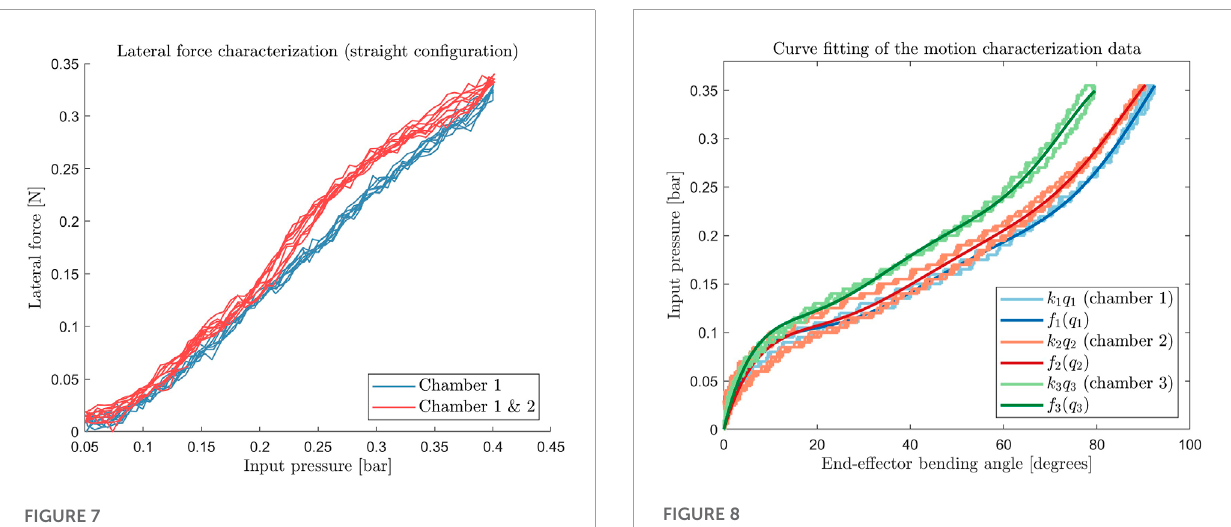
FIGURE 7 Static lateral force measurement of the soft pneumatic actuator module. The force is measured over the range of operating input pressure of 0 bar–0.4 bar.